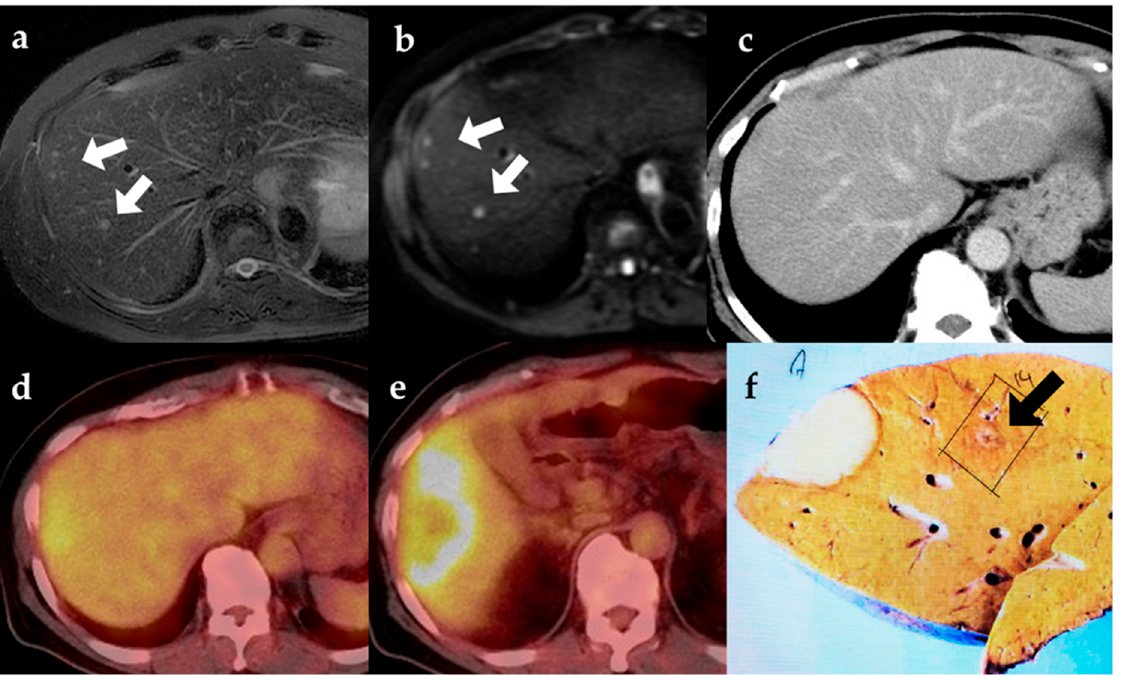
Figure 1. MRI ( a , b ) showed a satellite nodule (white arrow) separated from the main tumor, which was confirmed by histopathology (( f ); black arrow) but was not detected on CT ( c ) or PET-CT ( d , e ). ( a ) T2-weighted MR image, ( b ) Diffusion-weighted MR image (b factor = 800), ( c ) Contrast-enhanced CT, ( d ) PET-CT, ( e ) PET-CT showing main tumor, ( f ) Gross specimen.